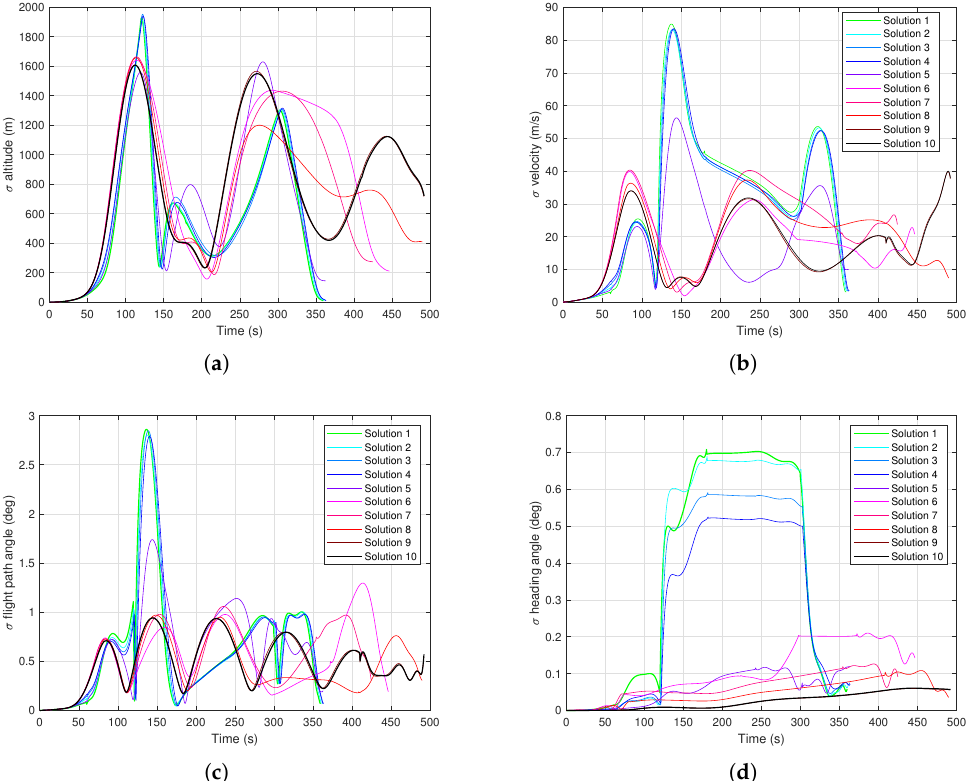
Figure 6. Standard deviations of state variables. ( a ) Altitude; ( b ) Magnitude of velocity; ( c ) Flight path angle; ( d ) Heading